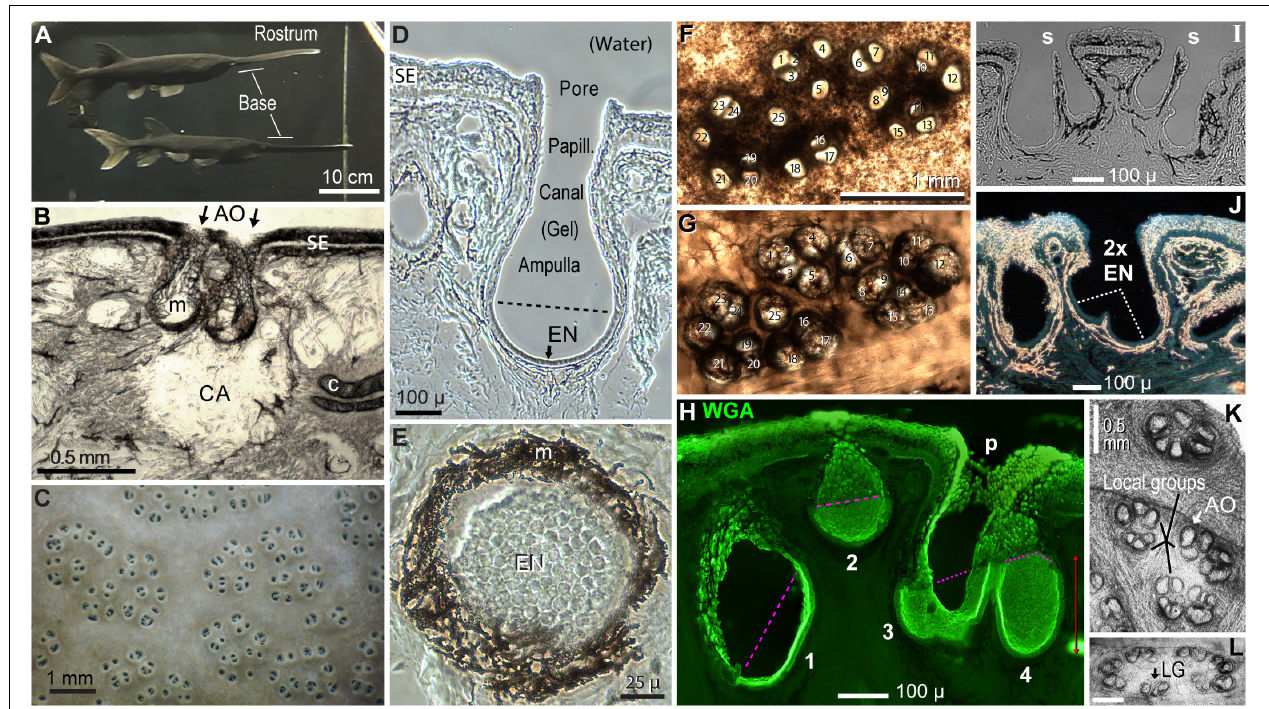
FIGURE 2 | Polyodon electroreceptors. (A) The rostrum and its base are labeled on two paddlefish in the colony aquarium. (B) This cross section of rostrum skin illustrates a clear area (CA) under ampullary organs (AO, arrows), at gaps in subdermal cartilage plates (c). m, Melanin pigment in fibrous AO walls. SE, Striated ectoderm skin. (C) Electroreceptor skin pores on the rostrum base of a live paddlefish in water. (D) Cross section of one ampullary organ. EN, Electrosensory neuroepithelium, below the dashed line. Papill., Lozenge-shaped papilla cells lined the canal and pore. (E) Planar patch of electrosensory neuroepithelium (EN) in a section that grazed the wall of an ampullary organ. (B,D,E) Unstained phase contrast single images of tissue sections. (F,G) Correspondence 1:1 of 25 skin pores in a cluster (F) to 25 ampullary organs of the same cluster (G) , in a vibratome section cut parallel to skin at ∼ 400- µ depth. Panel (F) was left–right reversed for direct visual comparison to panel (G) , with corresponding numbering. Panel (F) was imaged from above by transillumination after stripping off a superficial pigmented layer. Panel (G) was imaged from below to reveal AOs as basal outpocketings delineated by melanin-pigmented fibrous connective tissue. (H–J) Variants of AOs. (H) AOs of different sizes (#1–4) were stained by wheat germ agglutinin (WGA) lectin in this stack projection from a 50- µ section. The superficial borders of electrosensory neuroepithelia were marked by pink dashed lines. p, Papilla cells lined the AO neck and pore. (I) Thin septa (s) separated pairs of AOs sharing common skin pores; brightfield image. (J) This large skin pore led to two electrosensory neuroepithelia (2x EN). Darkfield illumination revealed melanin pigment as gold-colored. (K,L) AOs formed subgroups (K) or a perimeter (L) , in en face transilluminated images of the deep faces of thick vibratome sections parallel to skin, bleached in H 2 O 2 . Calibration in (L) was 0.5 mm. LG, Local group of three ampullary